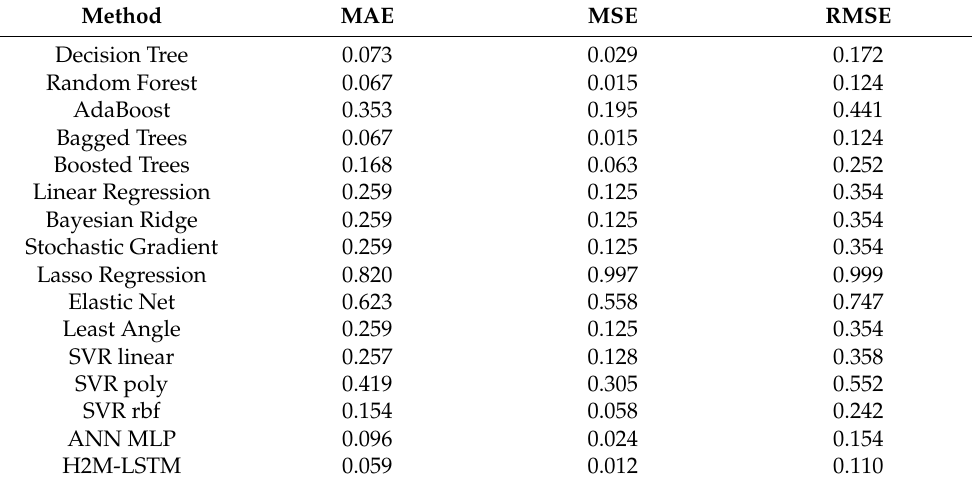
Table 2. Performance metrics for the solar